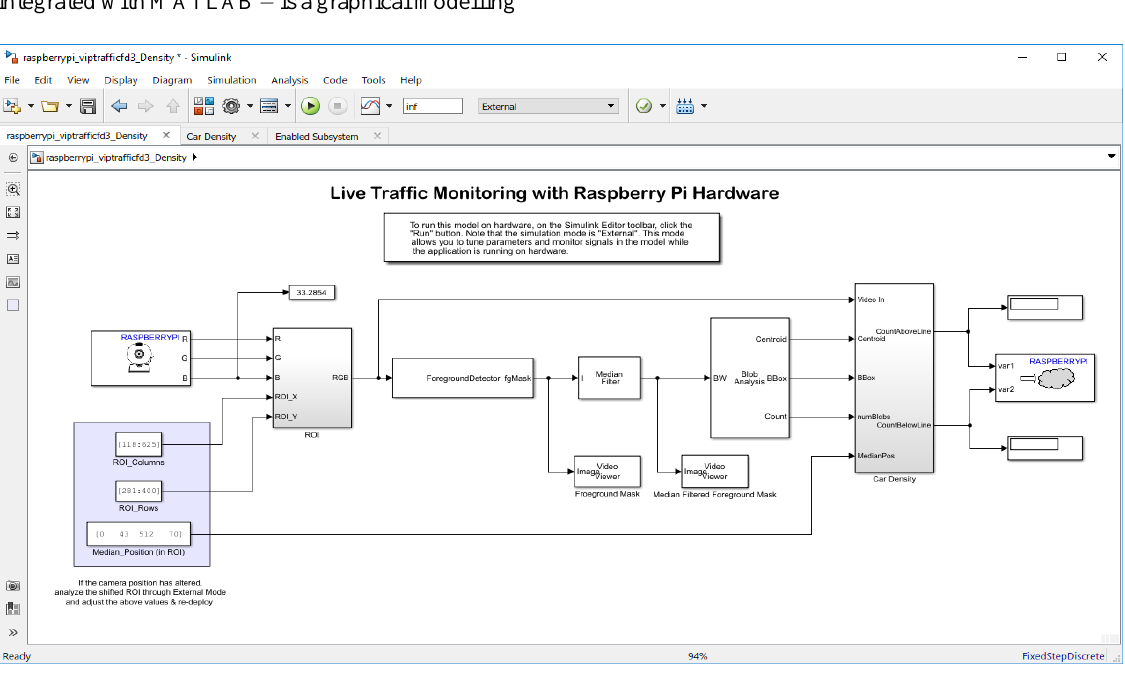
Fig.3. Simulink model for Traffic